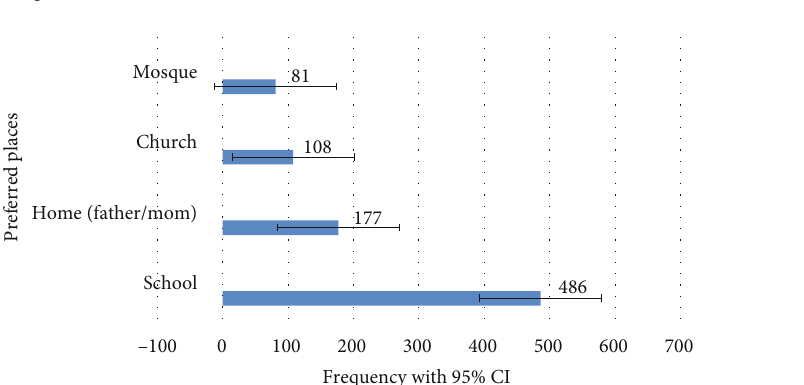
Figure 1: Source of information preference for sexual education and information by adolescents in Ambo Town, Oromia Region, Ethiopia,